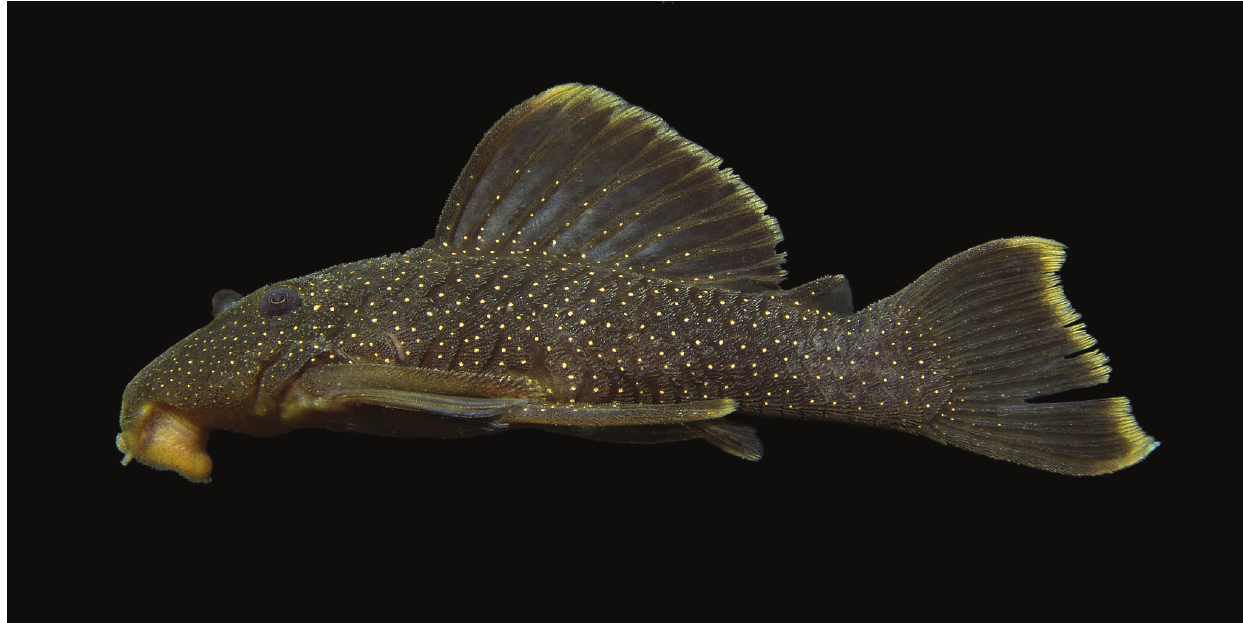
Fig. 2. Color in life of Spectracanthicus murinus (Image by L. M.